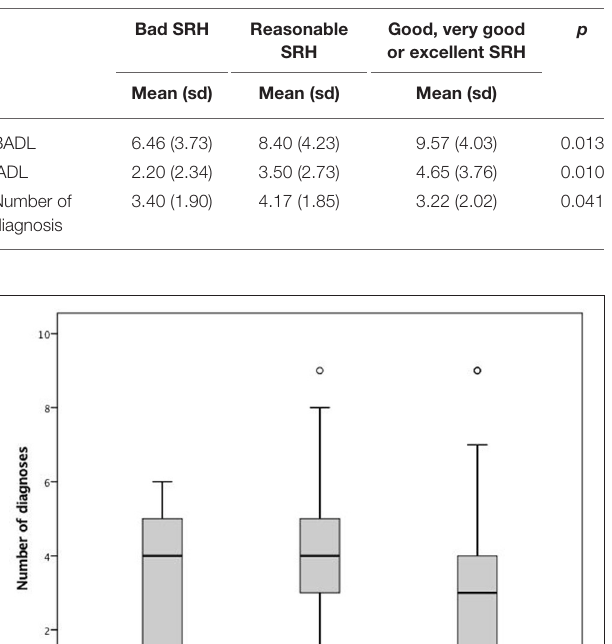
TABLE 3 | BADL, IADL, and number of diagnoses (mean scores) according to SRH.